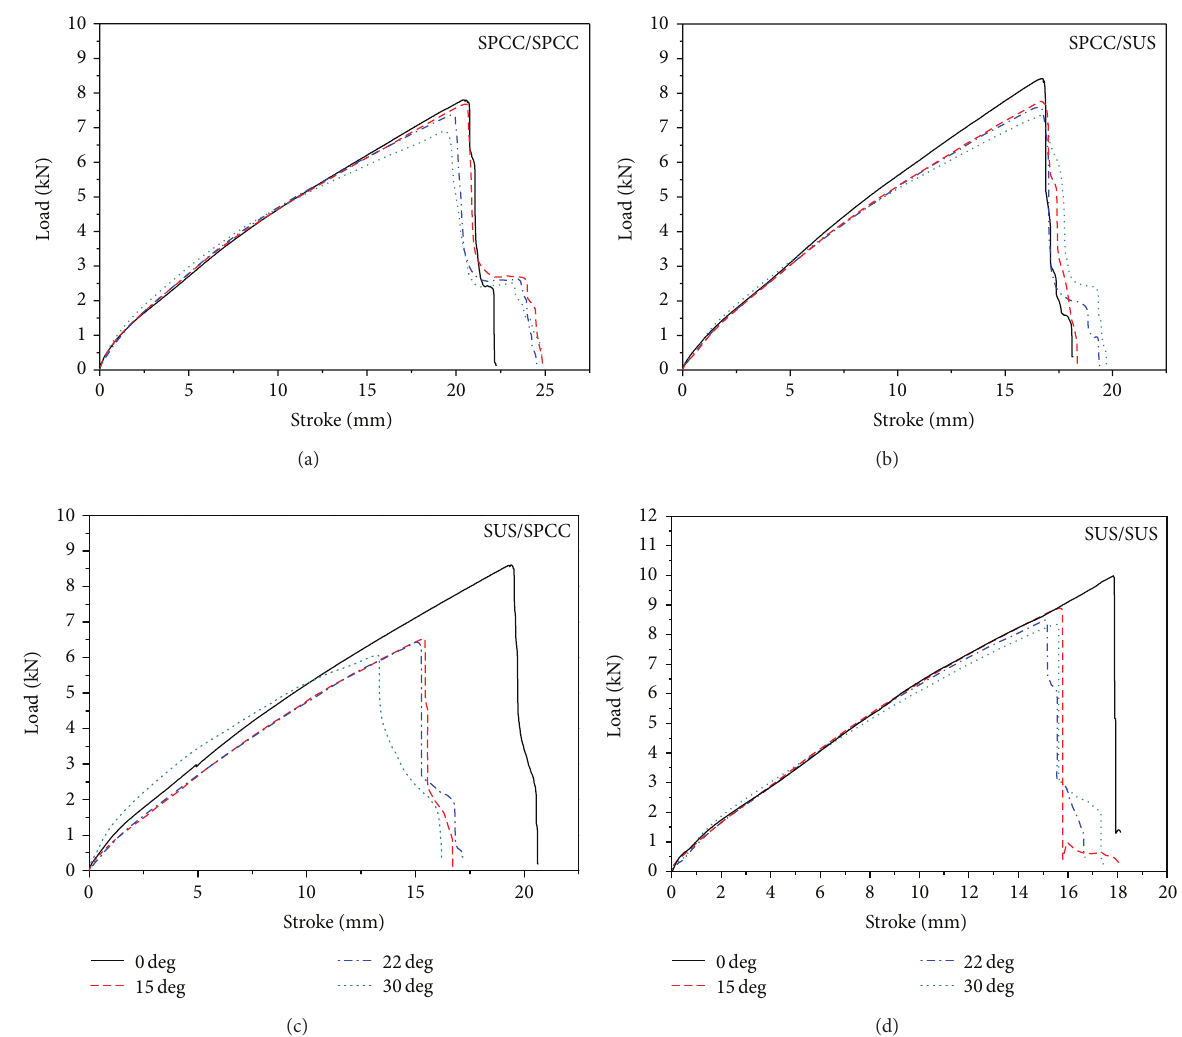
Figure 8: Load-displacement curves for FSSW joints of (a) SPCC/SPCC, (b) SPCC/SUS, (c) SUS/SPCC, and (d) SUS/SUS at four different loading